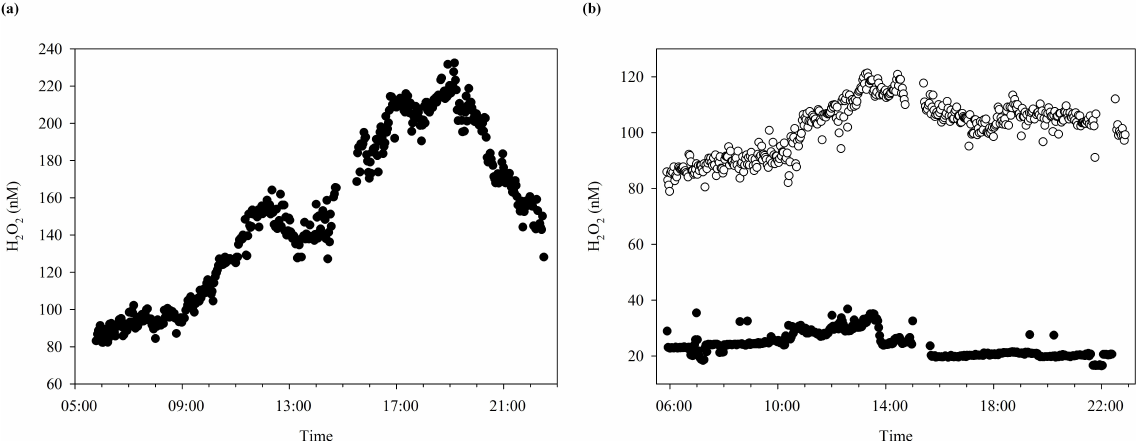
Figure 7. (a) Diurnal cycling of H 2 O 2 in coastal seawater (Gouves, Crete 17 May) and (b) in the no addition tank (number 11) during the MesoMed mesocosm on 15 May (open circles) and 19 May (closed circles) 2016 (experiment days 4 and 8, respectively).